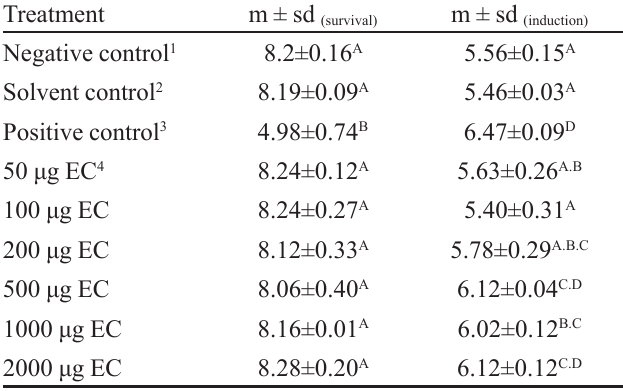
TABLE I - Mean (m) and standard deviation (sd) of number of colonies (survival assessment) of E. coli WP2s(λ) and number of plaques (assessment of lysogenic induction) in RJF013